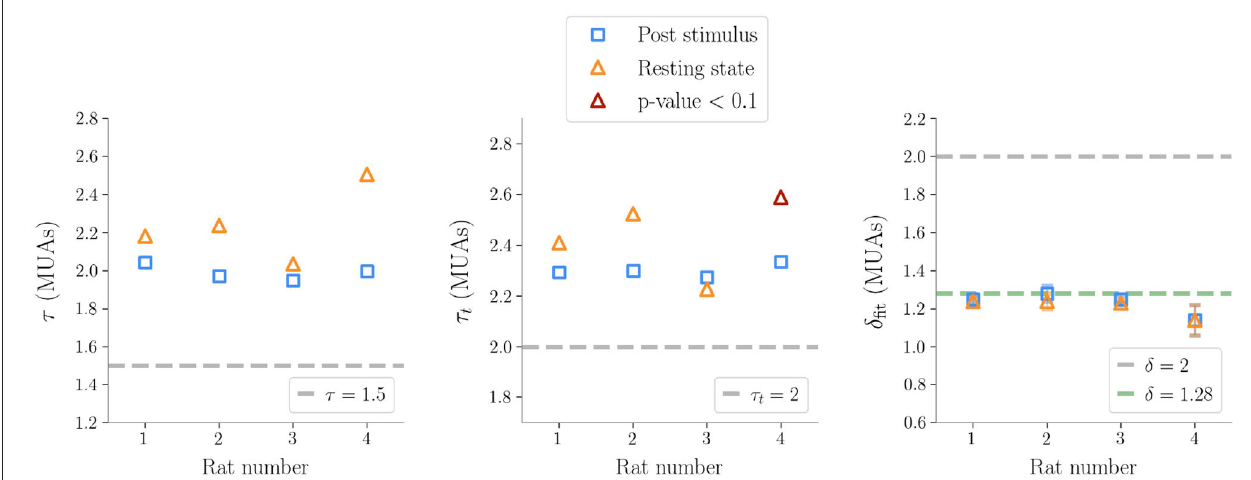
FIGURE 6 | Exponents obtained after subsampling in multi-unit activities data ( τ exponent for the sizes, τ t for the durations, δ fit the fitted exponents of the crackling-noise relation). The exponents predicted by the critical branching process are also plotted. The line δ fit = 1.28 is also plotted, which is found in Fontenele et al. (2019), and which turns out to be remarkably close to our